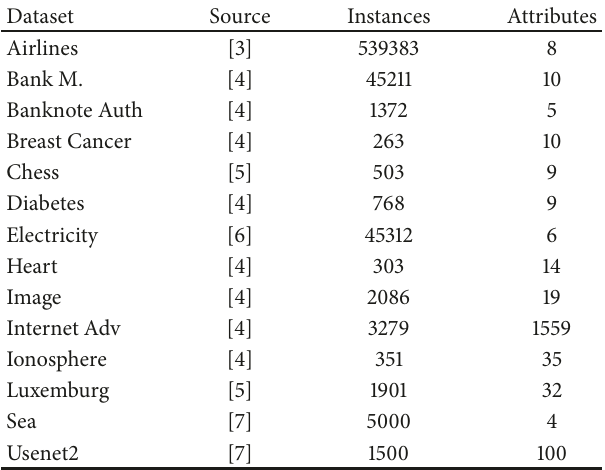
Table 1: Benchmark datasets used in the experiment. The table is reproduced from [2] (under the Creative Commons Attribution License/public